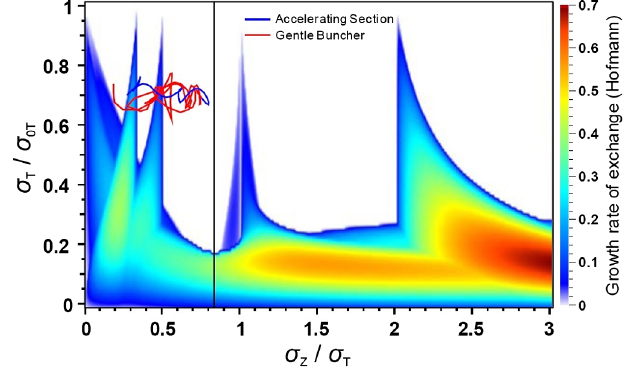
FIG. 5. The footprints of the RFQ phase advance.